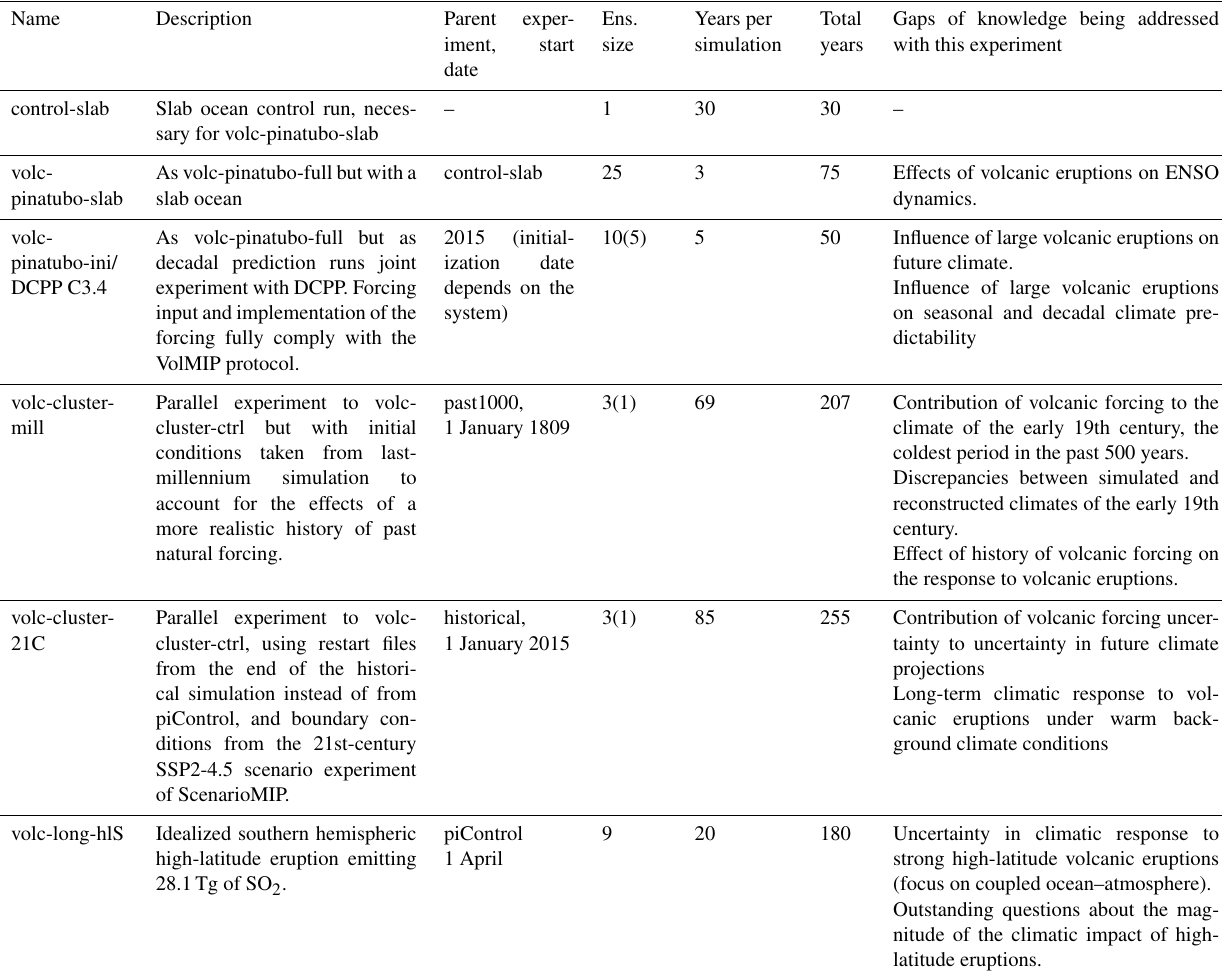
Table 3. Tier 3 VolMIP